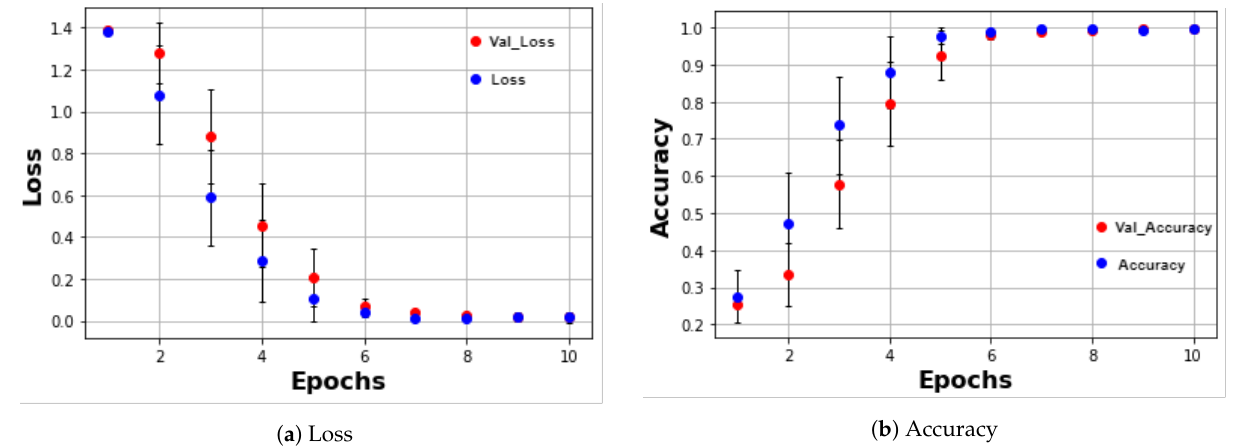
Figure 4. Model performance with a 95% confidence interval using a 10-fold cross-validation process. The blue points show the validation loss and accuracy whereas the red points represent the training loss and accuracy, respectively.